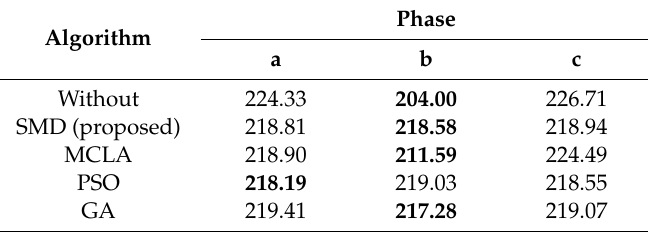
Table 13. The minimum value of the phase voltages at the level of the farthest pillar (P95). Phase Algorithm a b c Without